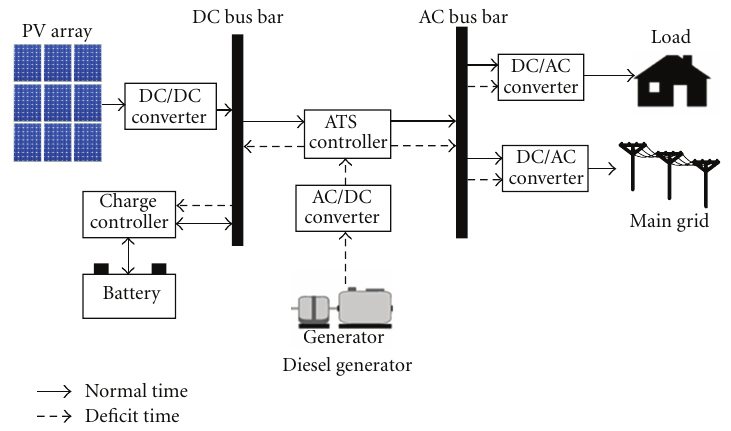
Figure 9: Components in a hybrid PV/diesel